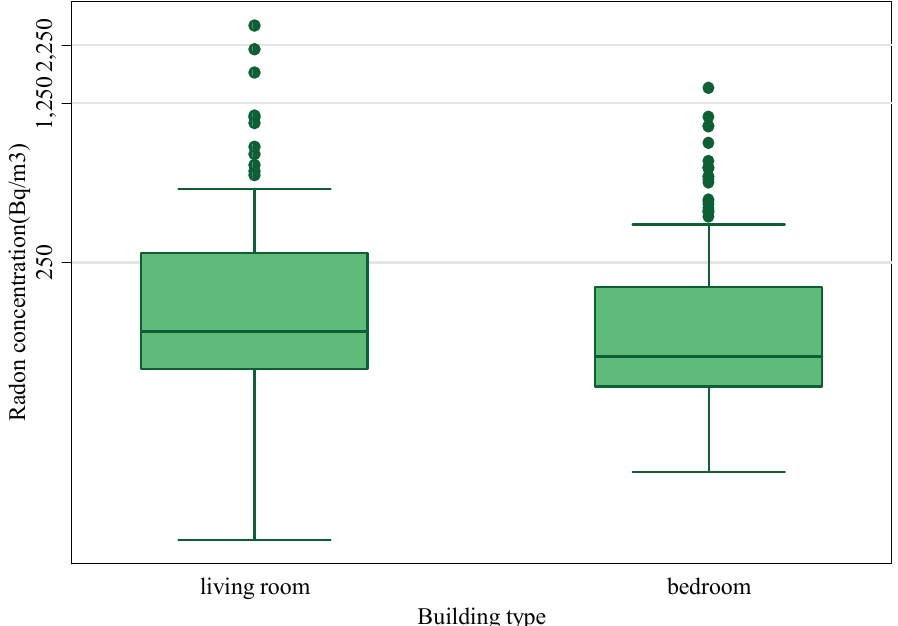
Figure 4. Relationship between radon concentrations and room